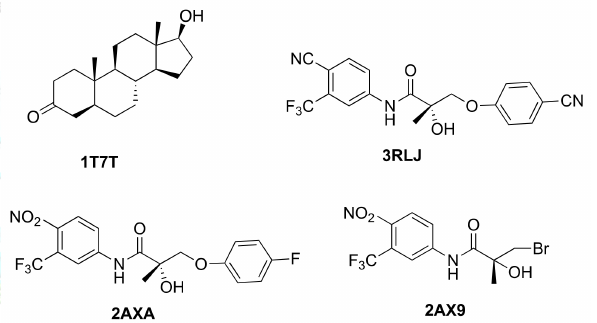
Figure 7. AR agonists used for the generation of the ensemble of agonist AR